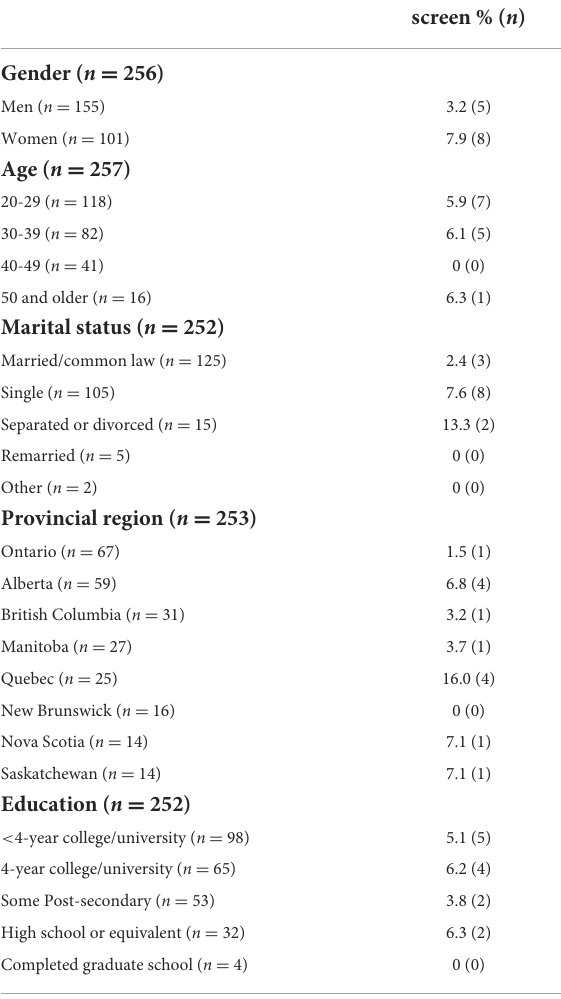
TABLE 1 Demographic information. TABLE 2 Total sample current and lifetime mental health disorders. Mental disorder screening